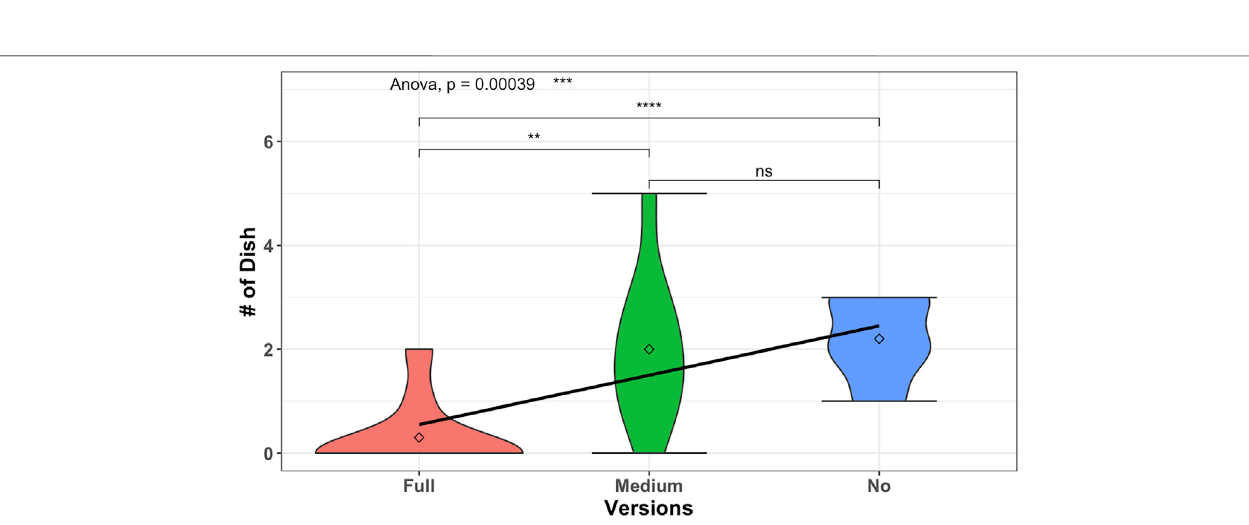
Frontiers in Robotics and AI |